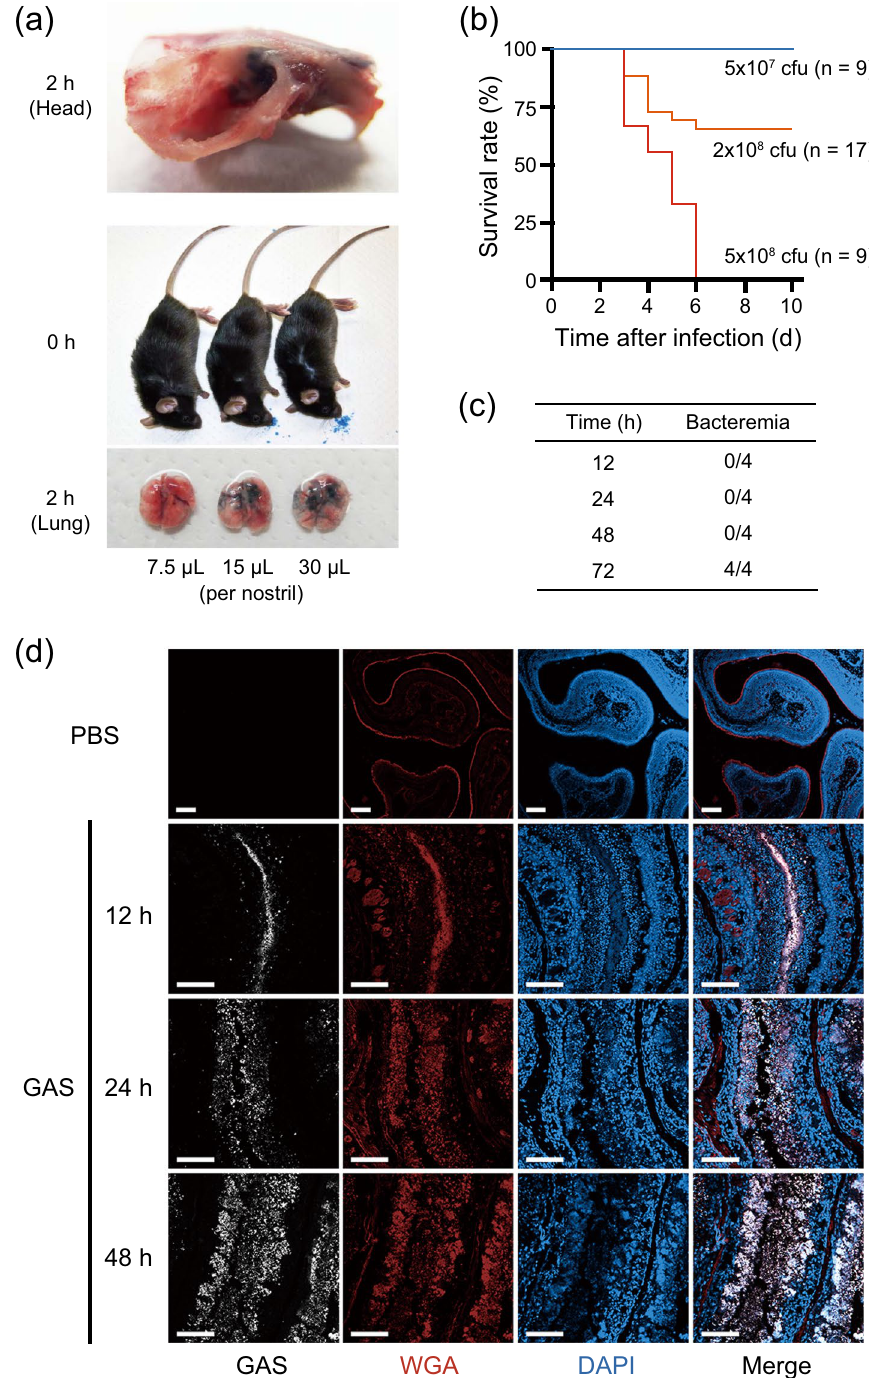
Figure 1. Establishment of the lethal mouse model of GAS pharyngitis. ( a ) Inhalation range of nasal administration. (Top) Photograph of the head of a mouse 2 h after the administration of 7.5 μ L of Trypan blue solution into the bilateral nasal cavities. (Middle and bottom) Photographs of the head immediately after and lung tissue 2 h after the administration of the indicated volume of Trypan blue solution into the bilateral nasal cavities. ( b ) Survival curves of mice intranasally infected with the ATCC 11434 strain. The survival curves of 6–7-week-old male C57BL/6 mice intranasally infected with the ATCC 11434 strain are presented (each group consisted of 9 or more mice). The survival rate of ATCC 11434 strain-infected C57BL/6 mice was dependent on the number of bacteria (Log-rank test; p < 0.01). ( c ) Number of mice with bacteremia after infection with the ATCC 11434 strain (n = 4 in each group). ( d ) The nasal cavity tissue sections of mice 12, 24, and 48 h after infection with 5 × 10 8 CFU of the ATCC 11434 strain were stained with an anti-GAS antibody (white), WGA (red), and DAPI (blue). PBS was inoculated as a negative control. Bars indicate 100 μ